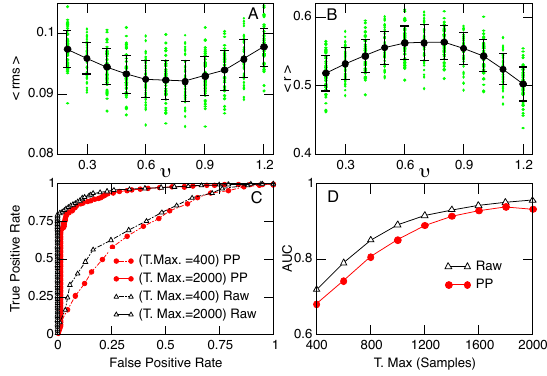
Figure 6: Panels A and B: Comparison of the partial correlation matrices –one calculated with the original BOLD data (Raw) and the other from its derived point process (PP)– as a function of the threshold ν used to define the point process. Panel A corresponds to the root mean squared values of the differences, and panel B to the correlation coefficients. Dots correspond to in- dividual results while averages (filled circles) and error bars correspond to the mean and standard deviation of the 50 simulated BOLD records (time series length T=200 samples) Panel C shows the Receiver Operating Characteristic curve obtained for both methods in de- tecting the presence of links ( ν = 0 . 7 and σ = 2 . 2) com- puted for two time series of maximum length (T. Max. indicated in the legend). Panel D corresponds to the area under the ROC curve, computed for both meth- ods as a function of the increasing maximum length, T. Max., of the time series